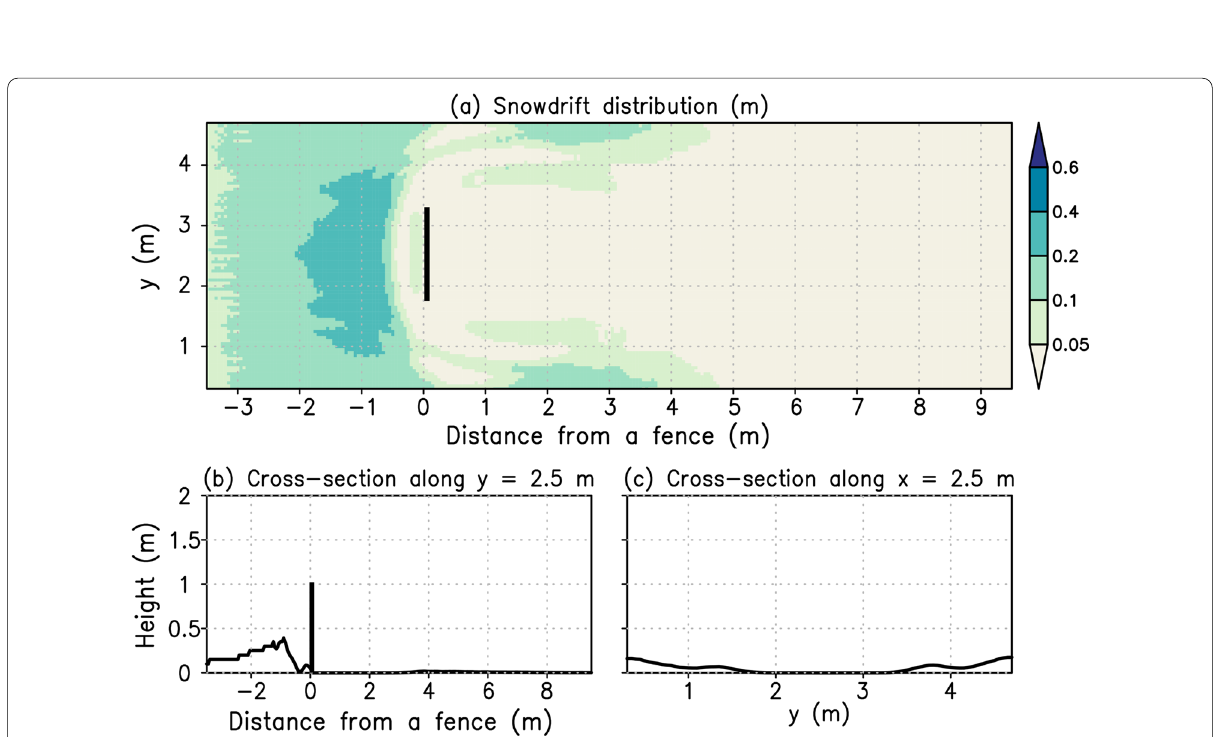
Fig. 11 a Snowdrift height around the three-dimensional fence in the cross section along b y the amount of snow accumulation of each trajectory calculation. The position of the fence is shown by a solid line in a and